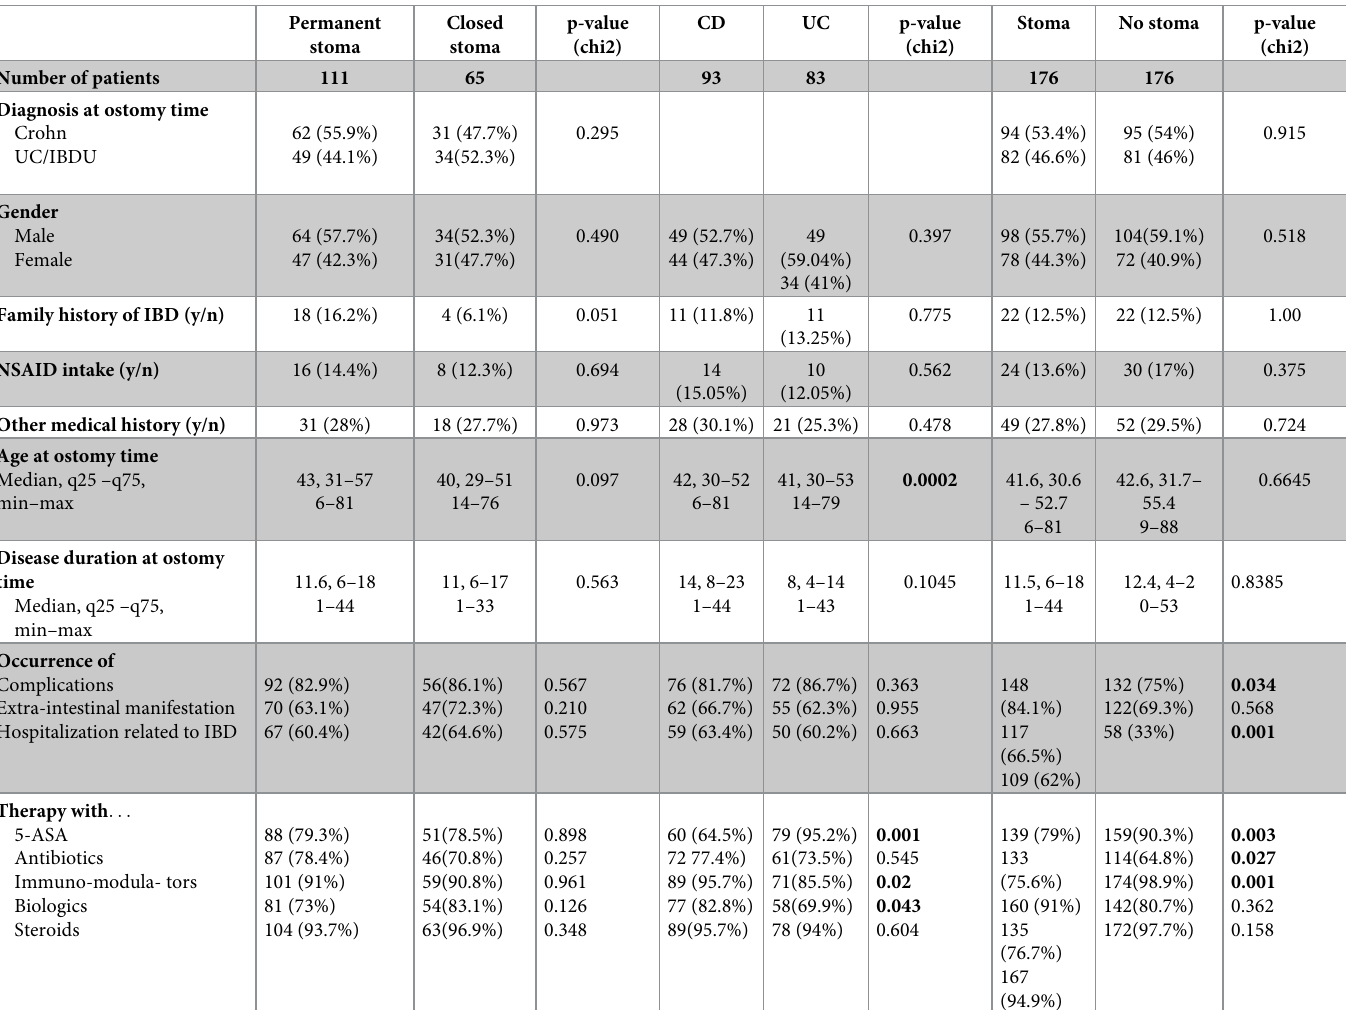
Table 1. Patient characteristics in different